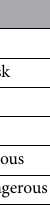
Table 1. Noise sensitivity index (Source 10